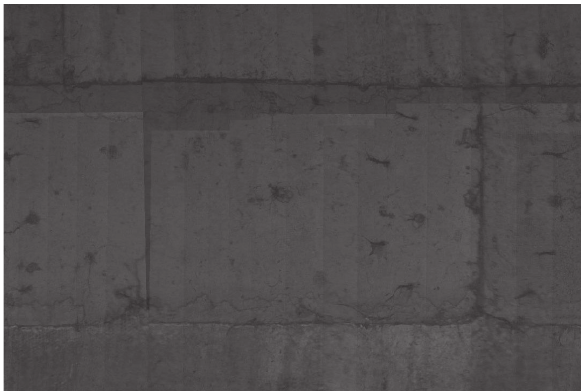
Figure 9: A detailed view of a small region in a mosaicked image by a simple superposition with luminance and color